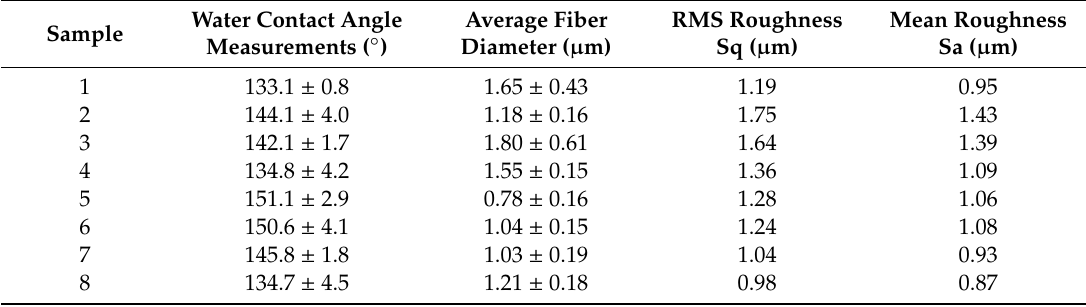
Table 2. Summary of the WCA values, average fiber diameter, RMS roughness, and mean roughness of all the samples of study.